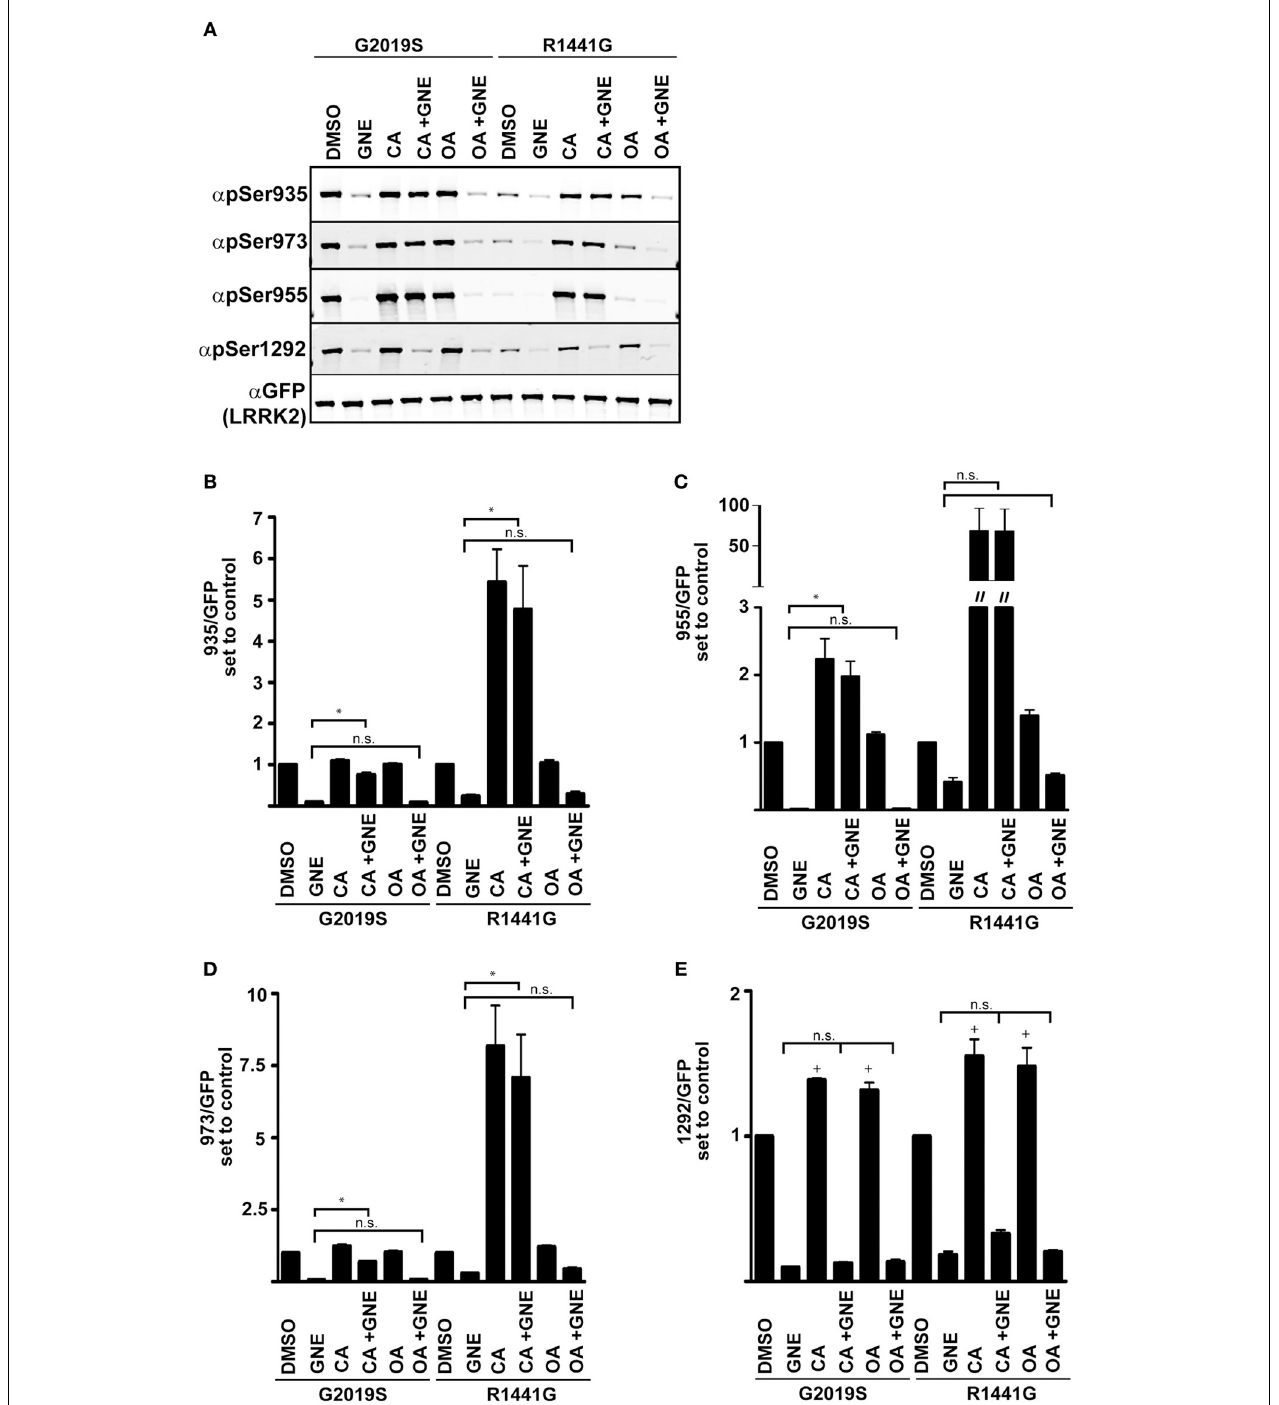
FIGURE 5 | Serine 1292 is regulated by Calyculin A and Okadaic acid sensitive phosphatases. Stable-inducible HEK 293 T-REx cell lines overexpressing Gly2019Ser or Arg1441Gly LRRK2 mutation were treated with Okadaic acid or Calyculin A alone, or combined with GNE1023. (A) Representative blots of phosphorylation levels in Gly2019Ser and Arg1441Gly LRRK2 mutation line. (B–E) Quantification of anti-phospho-Ser935, anti-phospho-955, anti-phospho-973, and anti-phospho-1292 phosphorylation levels relative to the DMSO treated control of each mutant. The immunoblots